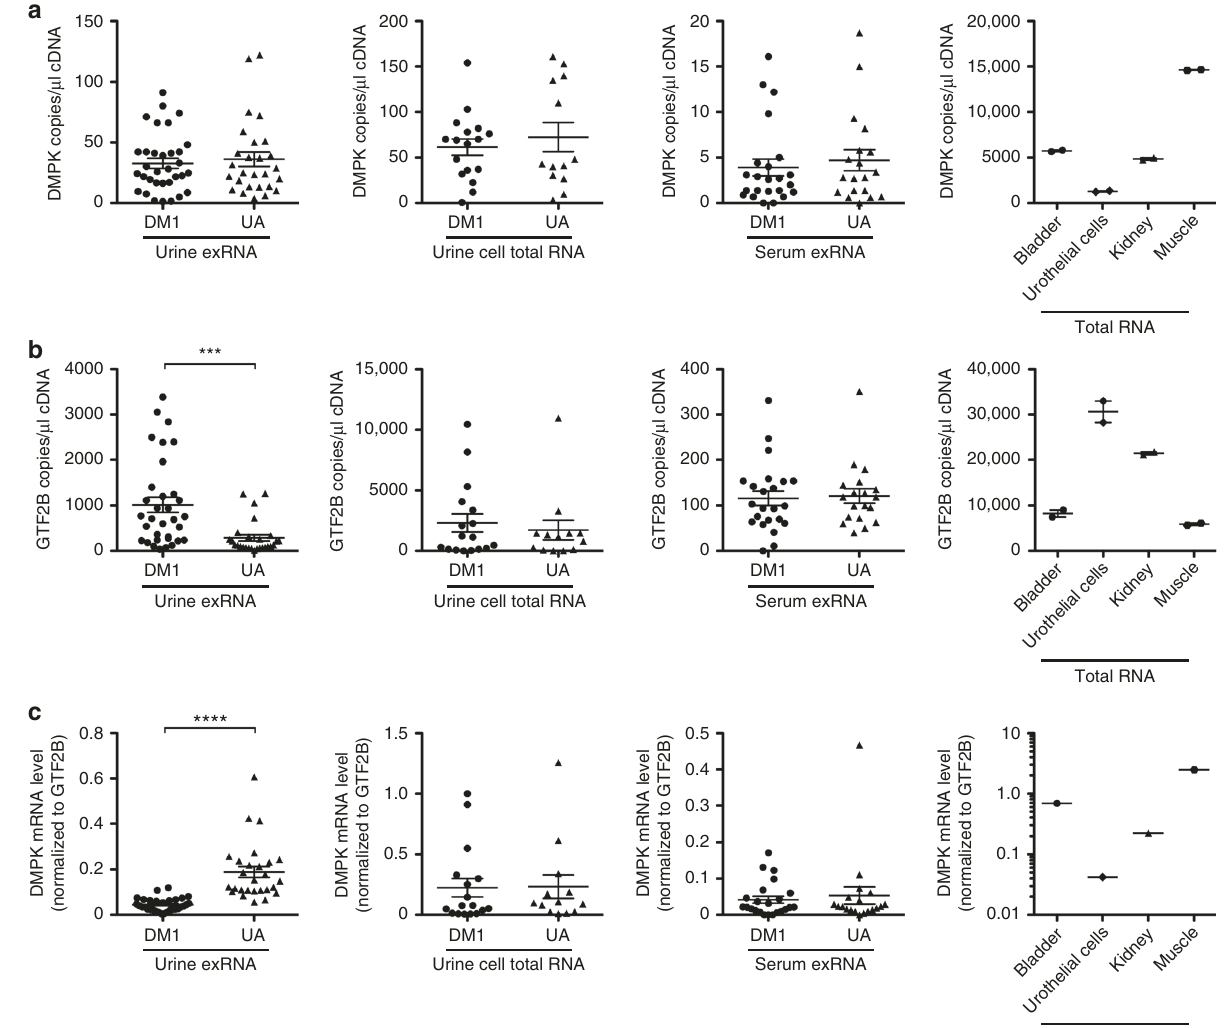
Fig. 1 DMPK gene expression in human urine and serum. We used droplet digital PCR (ddPCR) to examine gene expression in extracellular RNA (exRNA) from urine ( N = 33 DM1 patients and 27 UA control subjects without muscular dystrophy), total RNA from urine cells ( N = 17 DM1 and 13 UA controls), serum exRNA ( N = 23 DM1 and 19 UA controls), and commercially available total RNA from human bladder tissue, urothelial cells, kidney tissue, and skeletal muscle tissue. a Expression of DMPK mRNA, and b reference gene GTF2B mRNA, as measured by RNA copy number per microliter of input cDNA. c DMPK expression normalized to GTF2B . Individual data points represent the mean of duplicate assays for each sample. Error bars indicate mean ± s.e.m. **** P < 0.0001; *** P = 0.0002 ( t test)